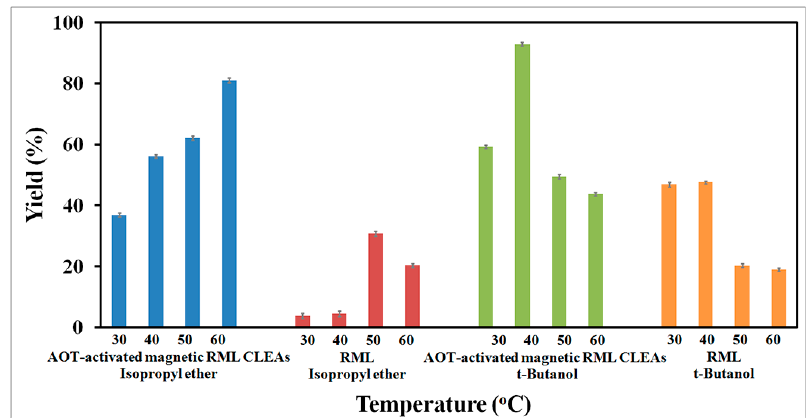
Figure 11. Effect of temperatures on AOT-activated magnetic RML CLEAs-catalyzed biodiesel production from jatropha oil in isopropyl ether and tert-butanol.